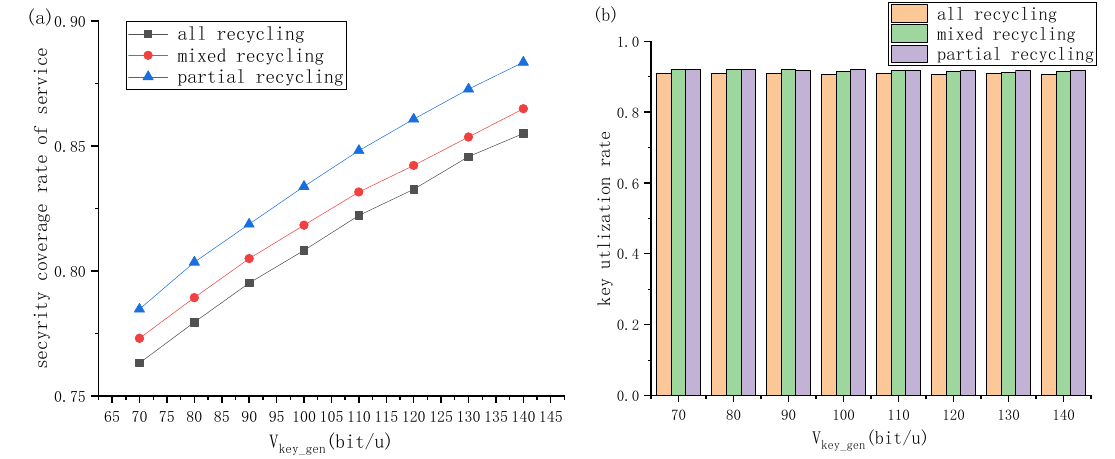
Figure 12. ( a ) The e ff ect of V key_gen on SCR and ( b ) KUR of QKD networks with di ff erent QKR Figure 12. (a) The effect of V key_gen on SCR and (b) KUR of QKD networks with different QKR mechanisms, when SFR is 30%. mechanisms, when SFR is 30%.